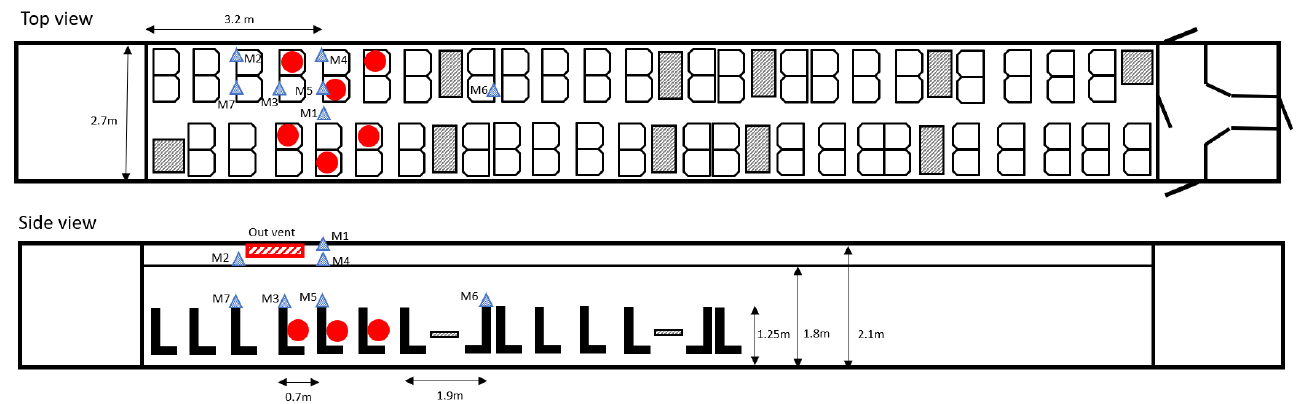
Figure 3. CO 2 experiment set up for middle of carriage. Red circles indicate position of passengers, and blue triangles indicate position of CO 2 sensors.